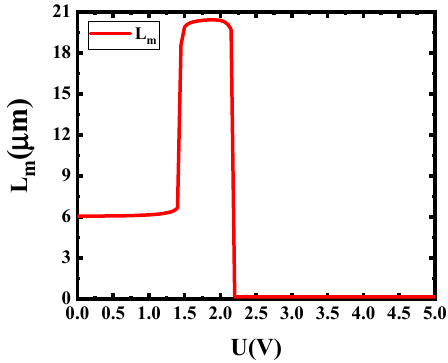
Figure 6. Dependence of L m on external voltage for the proposed modulator graphene electro-optical switch modulator based on silver nanowire (GESMBOSN).